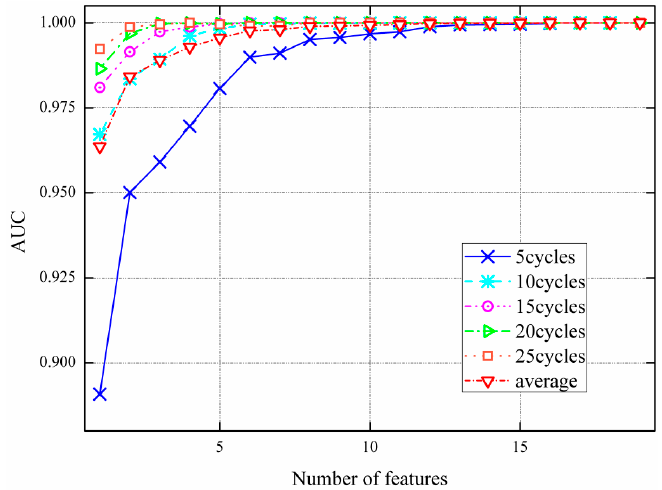
Figure 7. AUC for the voltage magnitudes feature subset.